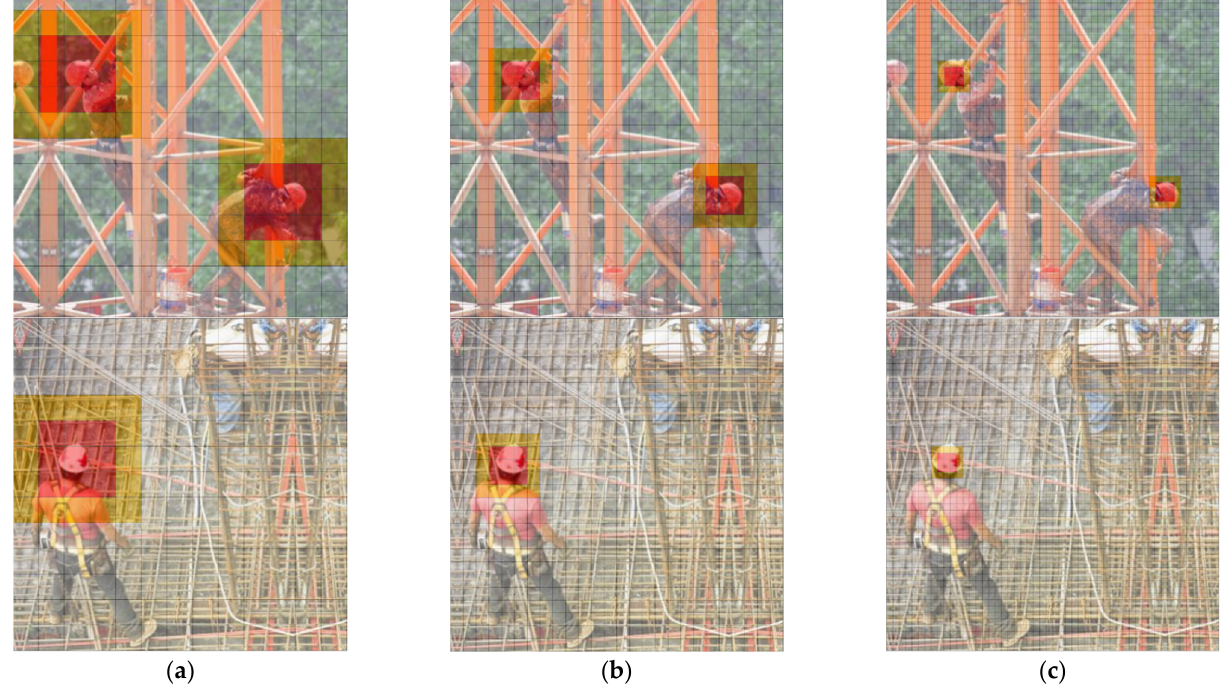
Figure 3. The multi-scale segmentation effect of the sample is shown. The segmentation scales are ( a ) 13 × 13, ( b ) 26 × 26, and ( c ) 52 × 52, respectively.